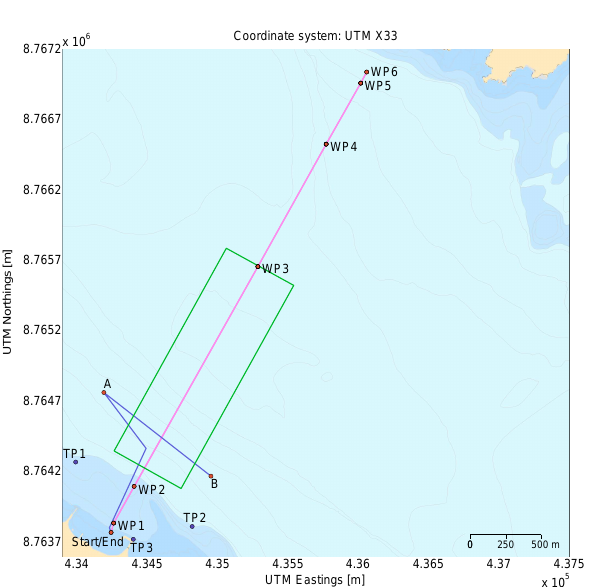
Figure 8: AUV trajectory for the cross-fjord survey. Blue line : Re-navigated trajectory calculated by the REMUS VIP software. Green/red crosses : Good/bad LBL fixes